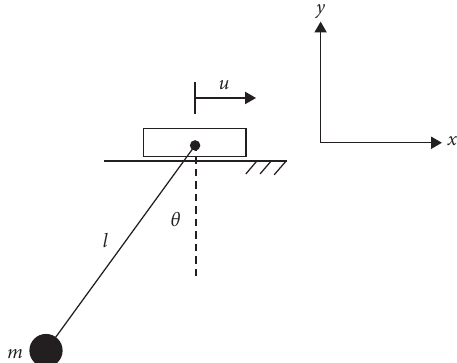
Figure 1: Overhead crane model with a massless